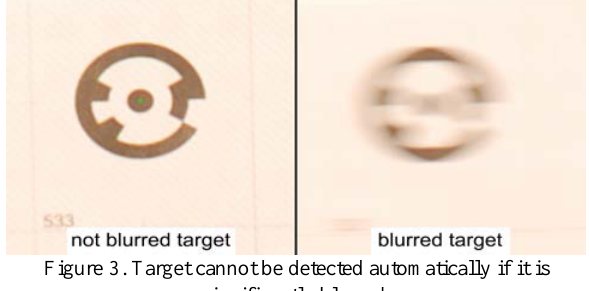
Figure 3. Target cannot be detected automatically if it is significantly